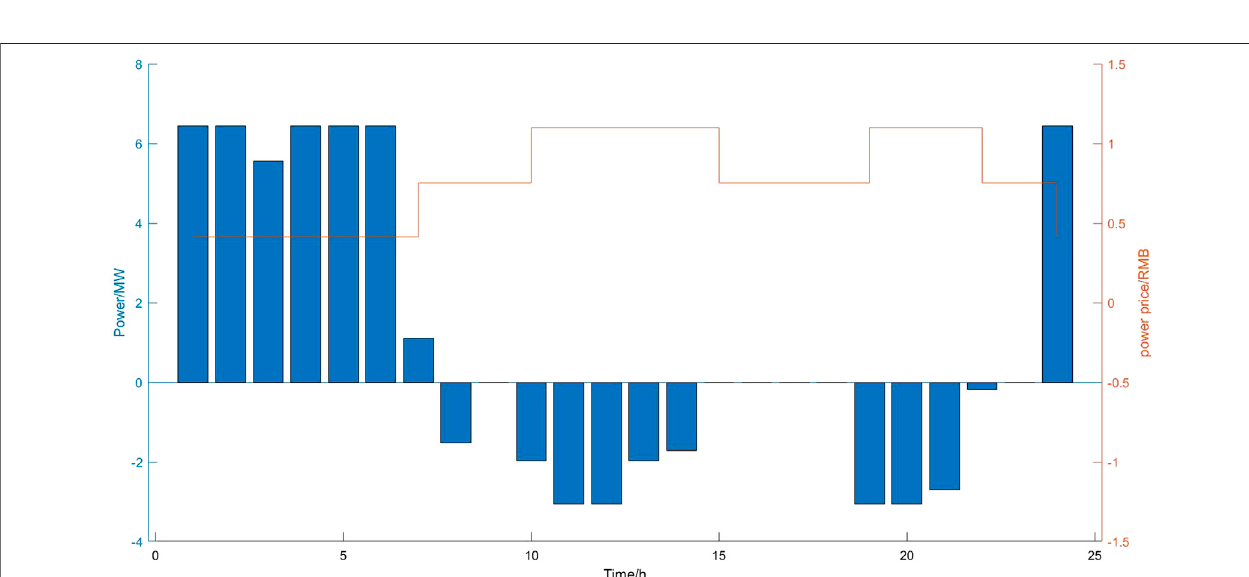
FIGURE 7 | Charging and discharging of EV clusters.